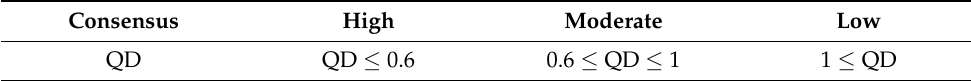
Table 2. QD consensus level